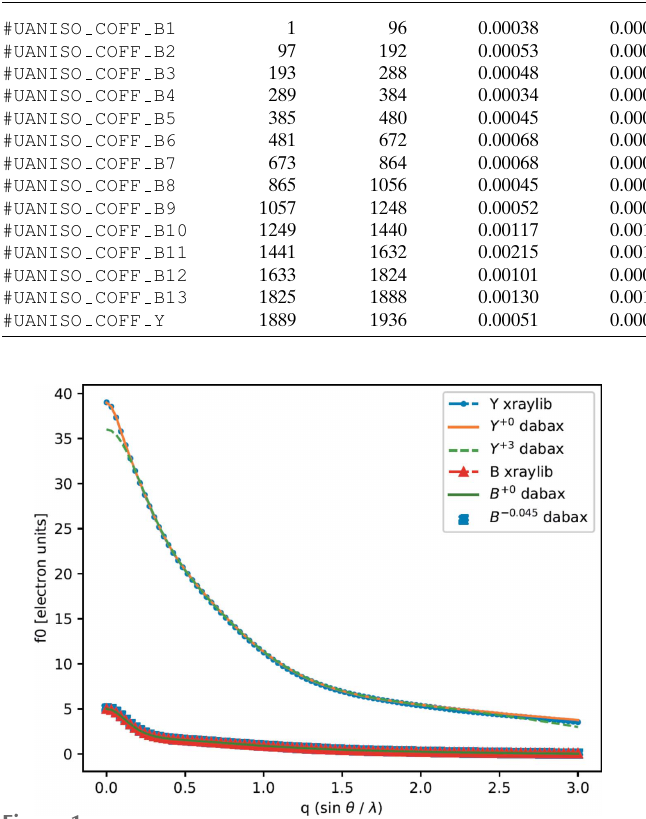
Figure 1 Plots of f 0 values against q for Yand B in their neutral form (as calculated by xraylib and DABAX ) and in their ionic state needed in the crystal YB